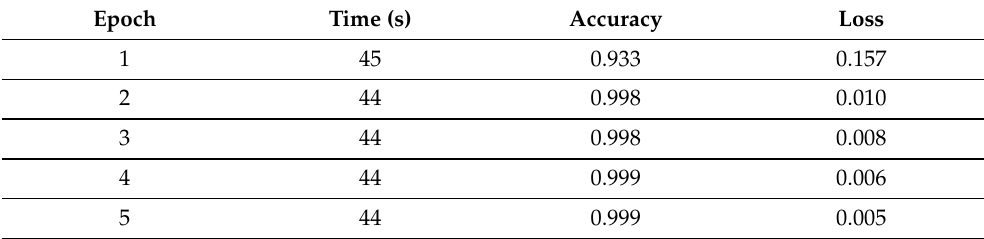
Table 6. Training dataset of 2 March 2018 with the feature set reduction through autoencoder.